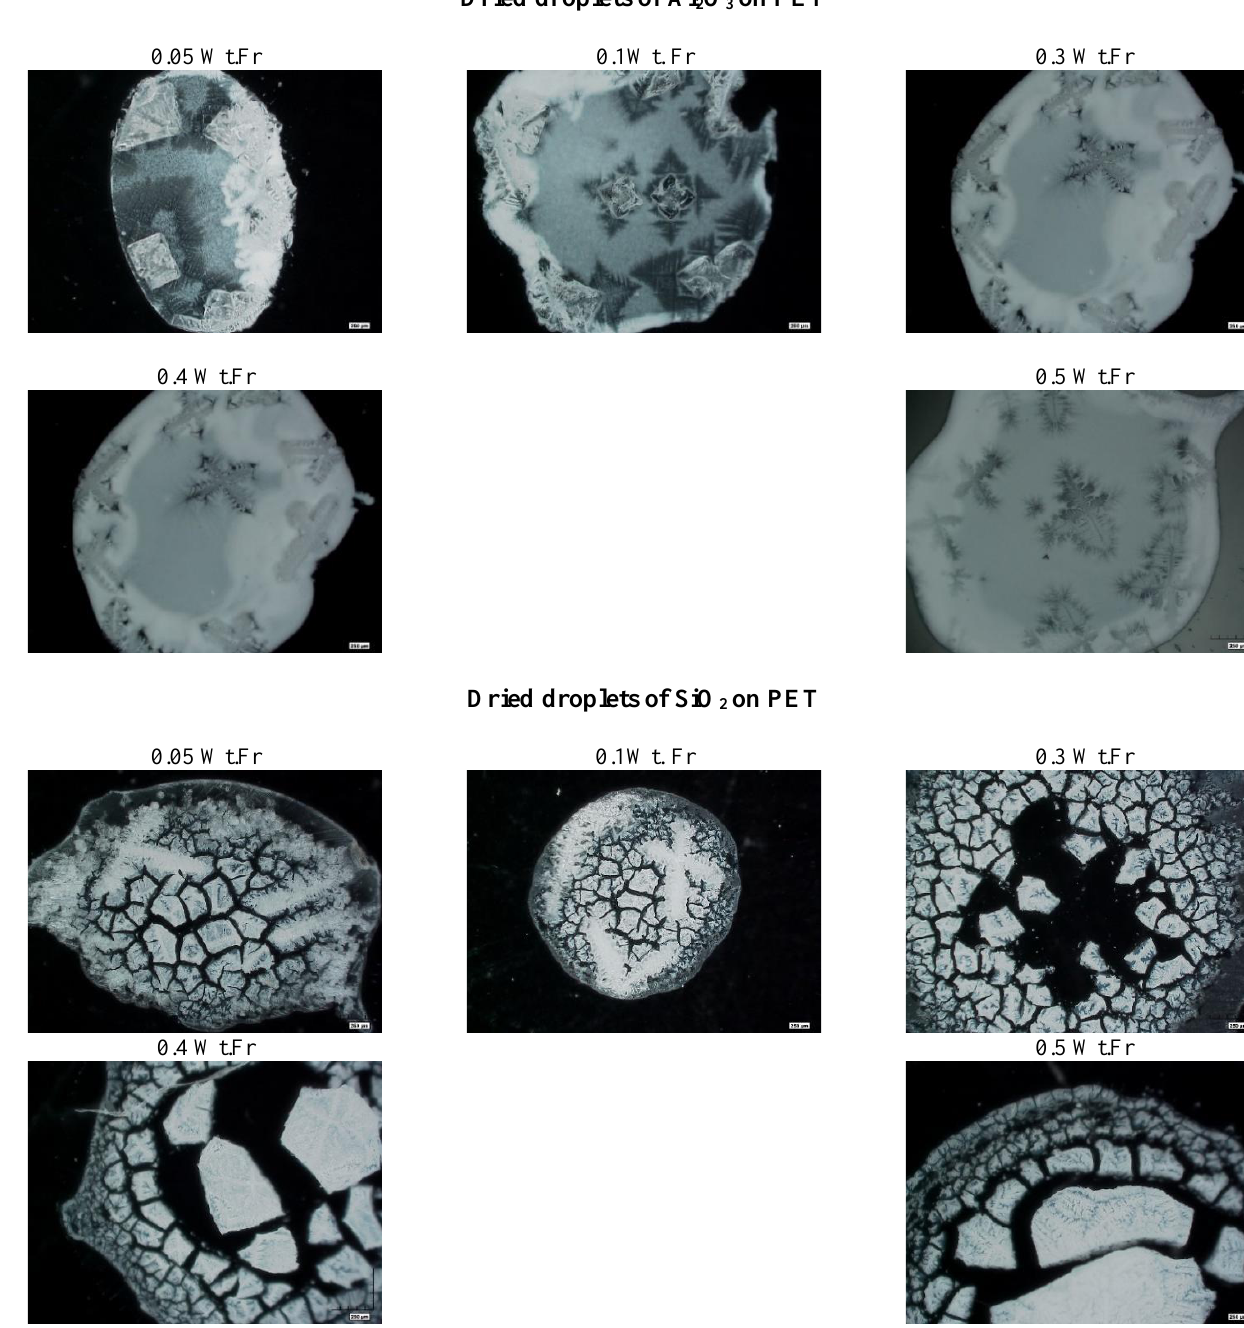
O and SiO suspensions where dendrites can be seen in all frames with Al 2 3 2 . At lowest concentration of Al 2 . Significant cracks are seen in SiO 2